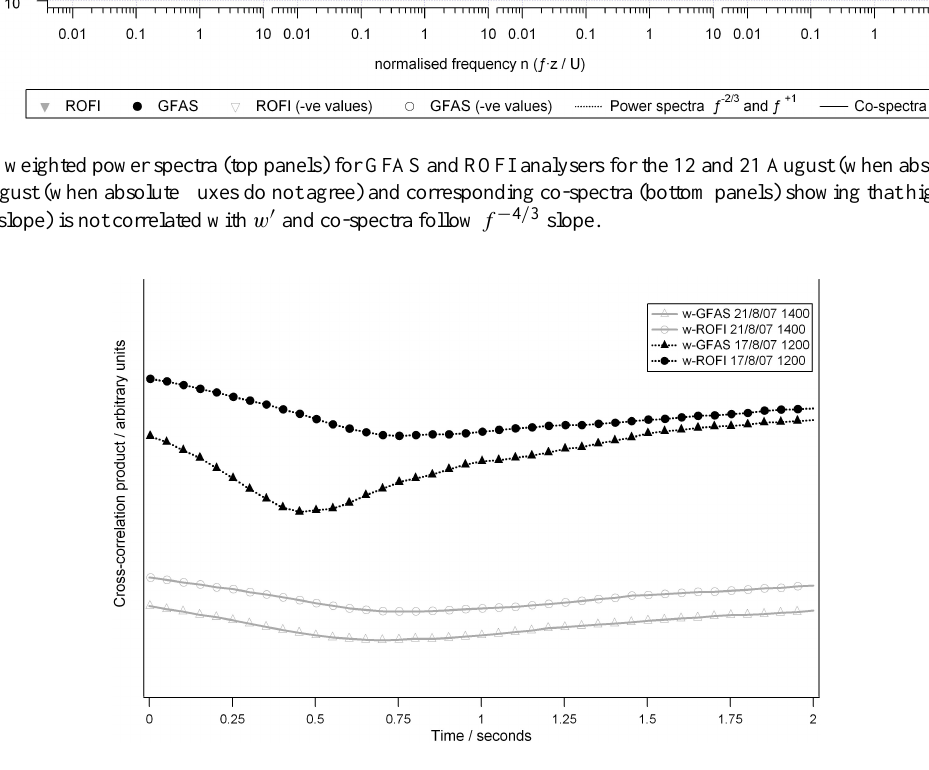
Fig. 8. Cross correlations of vertical windspeed w with both GFAS and ROFI. Black lines with solid symbols are for periods when fluxes do not agree (17 August 2007) and grey lines with open symbols for periods when fluxes agree (21 August